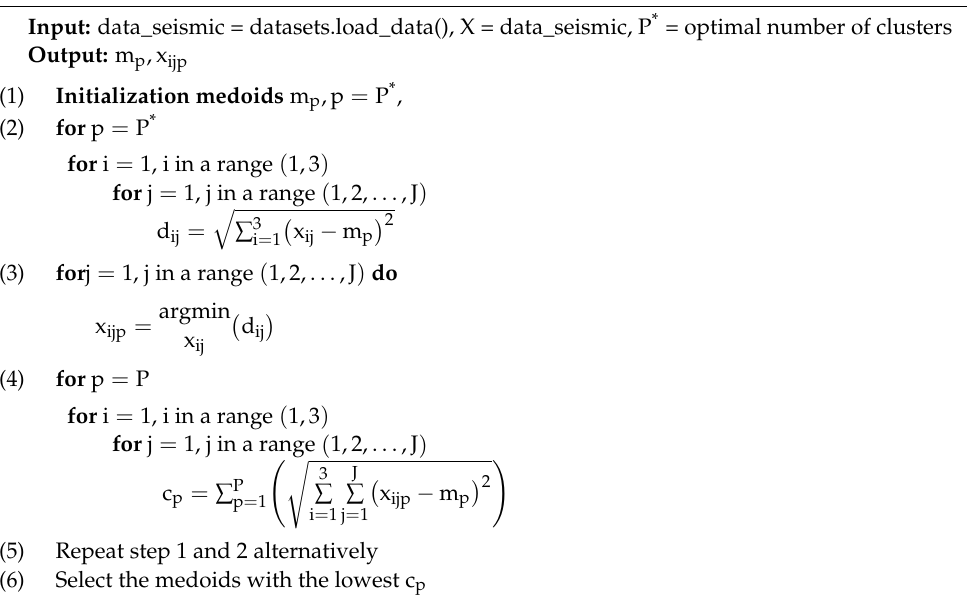
Algorithm 3. Pseudo code K-medoids